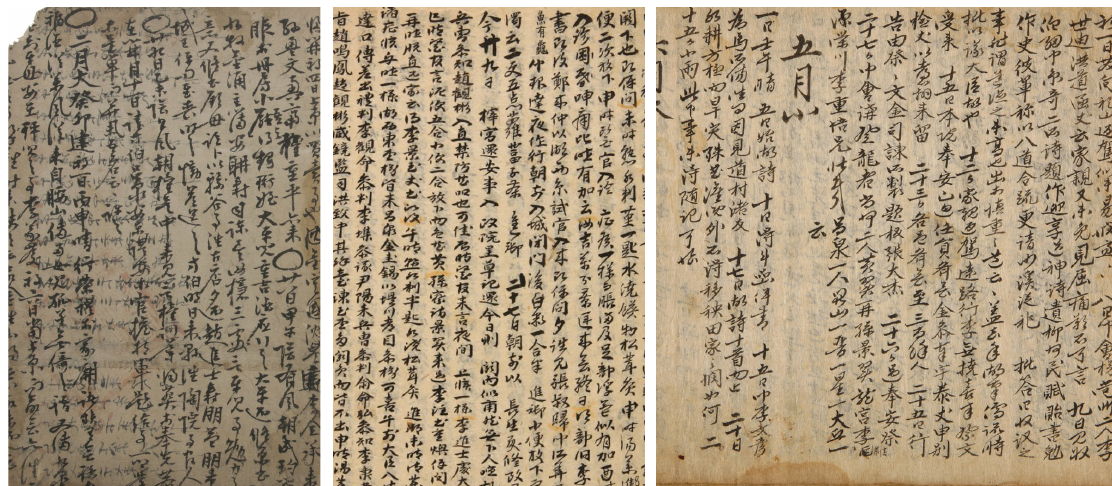
Figure 6. Example of problem caused by an unrestricted random parameter in augmentation.